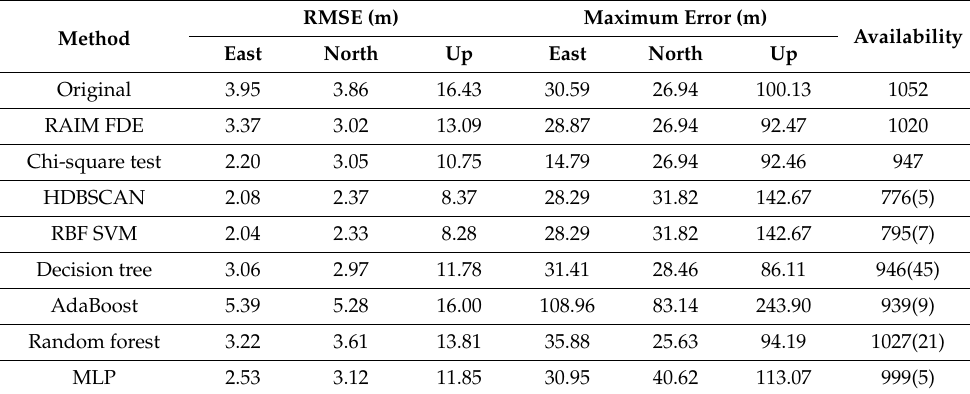
Table 9. Comparison of positioning accuracy and availability of D2 using di ff erent anomaly detection and exclusion methods.